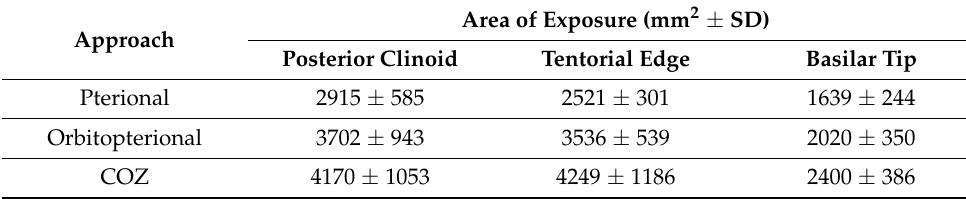
Figure 9. Comparison between pterional approach ( a ) and one-piece ( b ), two-piece ( c , d ), and three- piece ( e ) COZ approach. Table 1. Average Area of exposure of different targets according to Schwartz et al. [32].